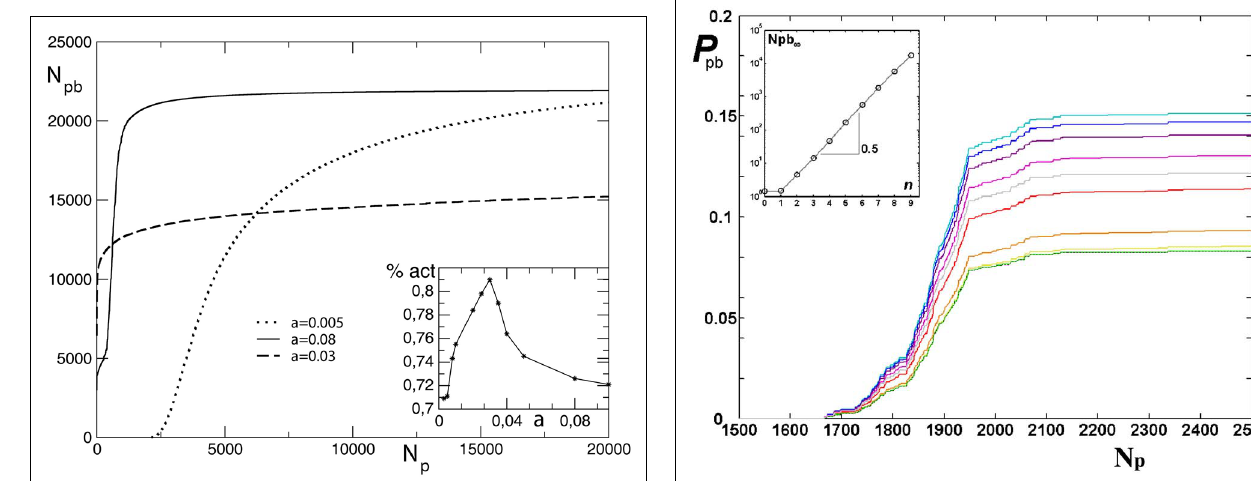
FIGURE 2 |Average number of pruned bonds N pb as function of the number of external stimuli N p for a square lattice of linear size L = 100, equal initial conductances, and different values of α . In the inset we show the asymptotic value of the percentage of surviving bonds as function of α .